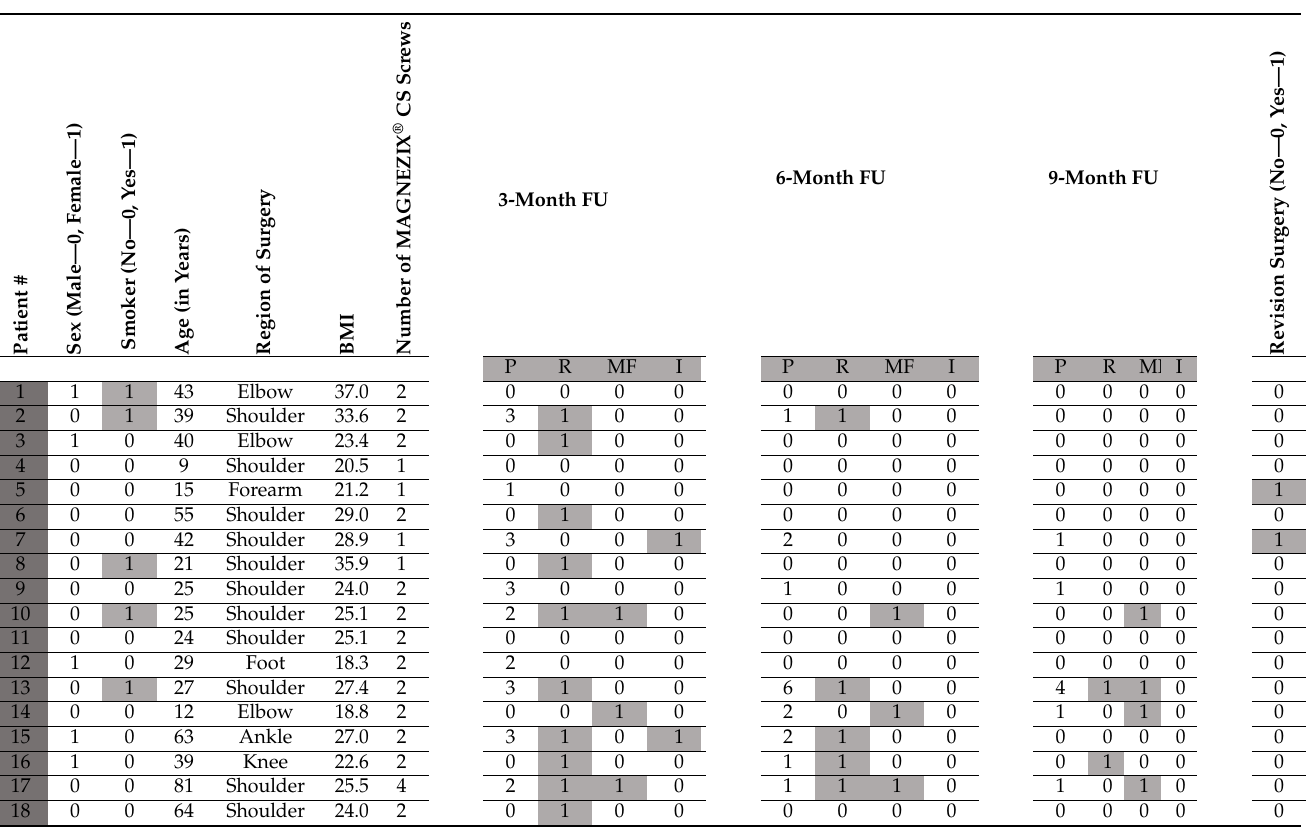
Table 1. Patients’ information: BMI = body mass index, P = pain (visual analogue